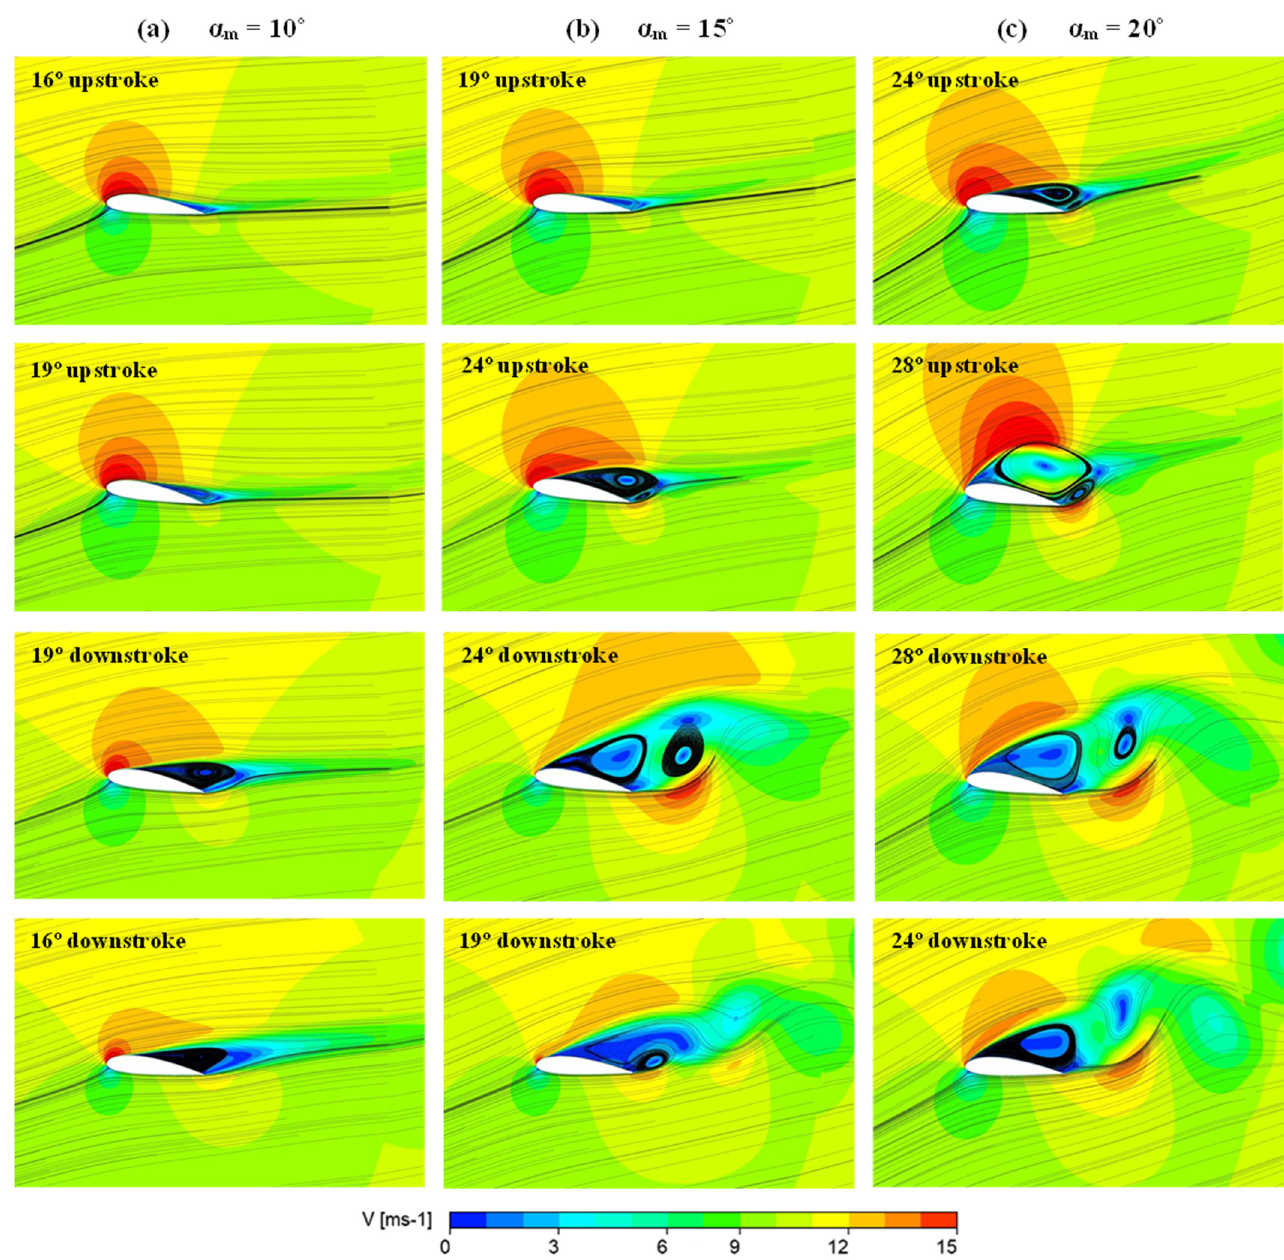
Figure 13. Velocity contours and streamlines during upstroke and downstroke motion for mean angles of ( a ) 10°, ( b ) 15°, and ( c ) 20°.